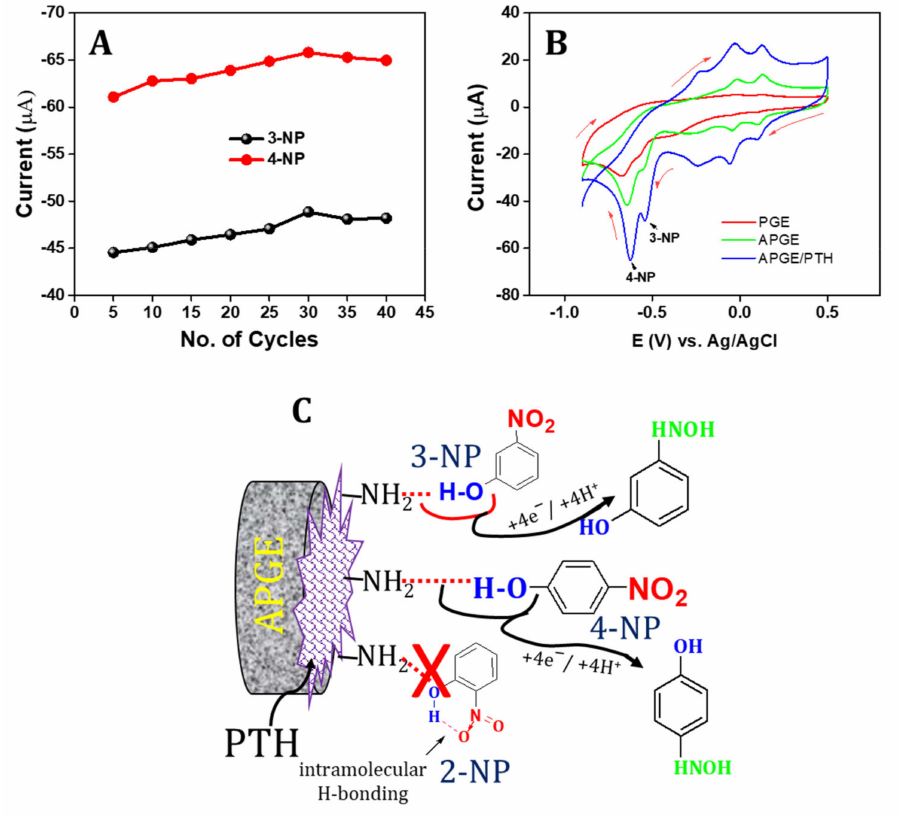
Figure 3. ( A ) The cathodic peak current dependence of 3-NP and 4-NP (20 µ M of each) on the number of cycles of the cyclic voltammogram during the thionine electrochemical polymerization, ( B ) Cyclic voltametric response of the different modified electrodes in 0.1 M PBS containing 20 µ M of 3-NP and 4-NP at scan rate of 50 mV/s and ( C ) Schematic representation of the proposed mechanism for sensing of 3-NP and 4-NP at APGE/PTH via hydrogen bond